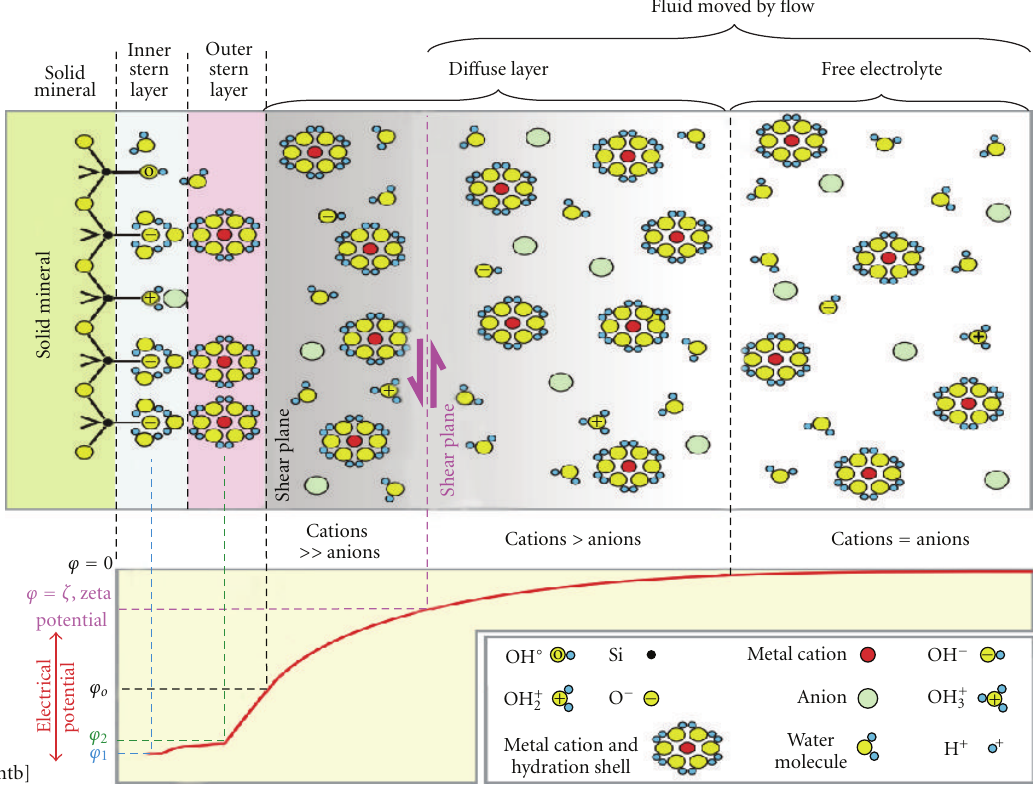
Figure 3: Electric double layer, first published in [81]. The solid mineral presented is the case of silica. At pH above the isoelectric point, the cations are adsorbed within the Stern layer; there is an excess of cations in the di ff use layer. The zeta potential is defined at the shear plane. The fluid flow creates a streaming current which is balanced by the conduction current, leading to the streaming potential.